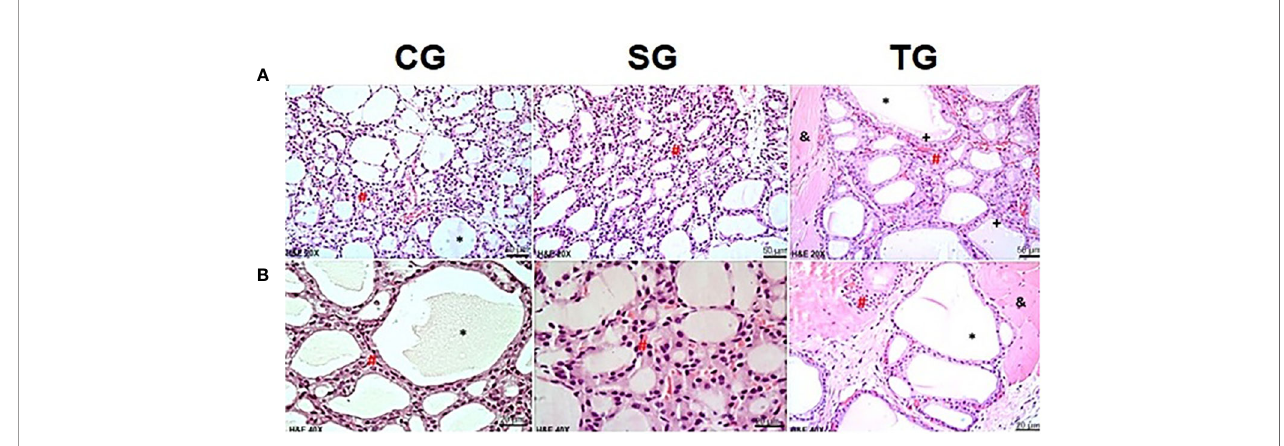
FIGURE 4 | Photomicrographs of the thyroid gland in CG, SG and TG in the 14th week. In the CG and SG, it was possible to observe intact thyroid follicles, consisting of a simple epithelial layer (#), whose content is fi lled with colloid (*). Images of the transplanted animals (TG) showed follicles containing numerous vesicles of endocytosis (+). In TG animals, the presence of muscle tissue was observed between follicular cells (&). (H&E, magni fi cation of x200 and x400). Scale bars = 50 for (A) Scale bars= 10 µm for (B)